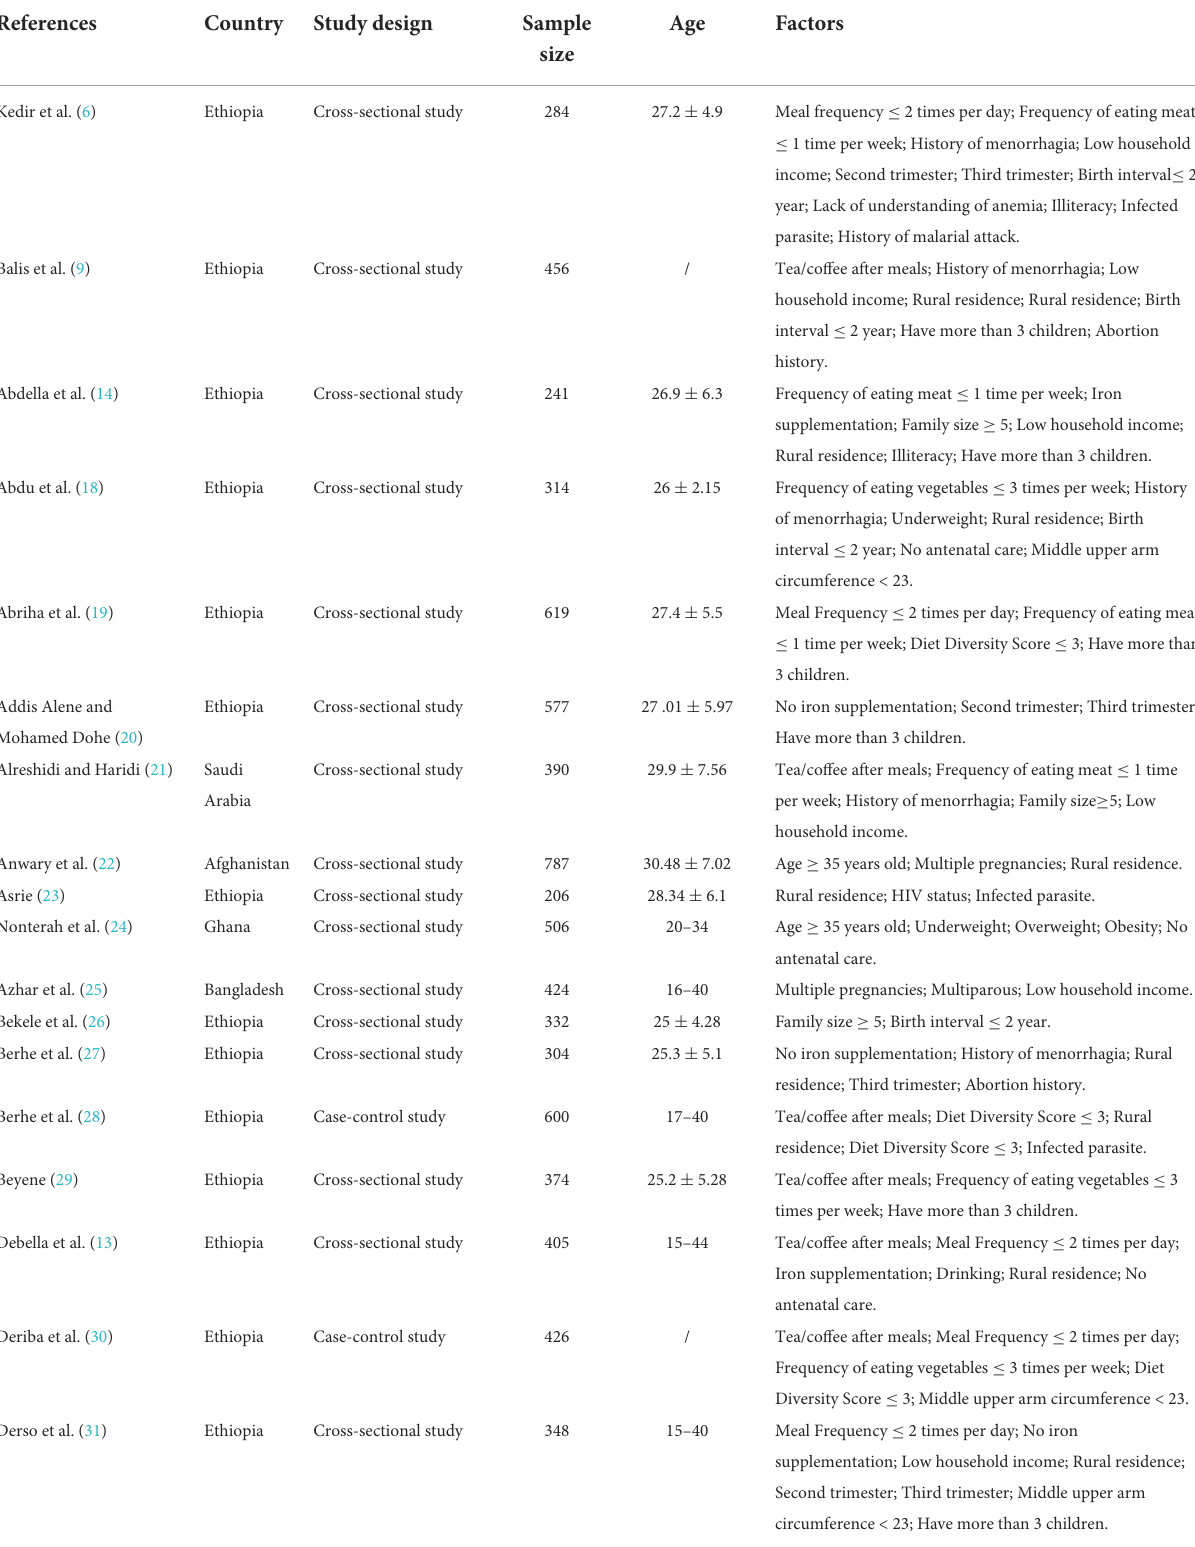
TABLE 1 Basic information of included